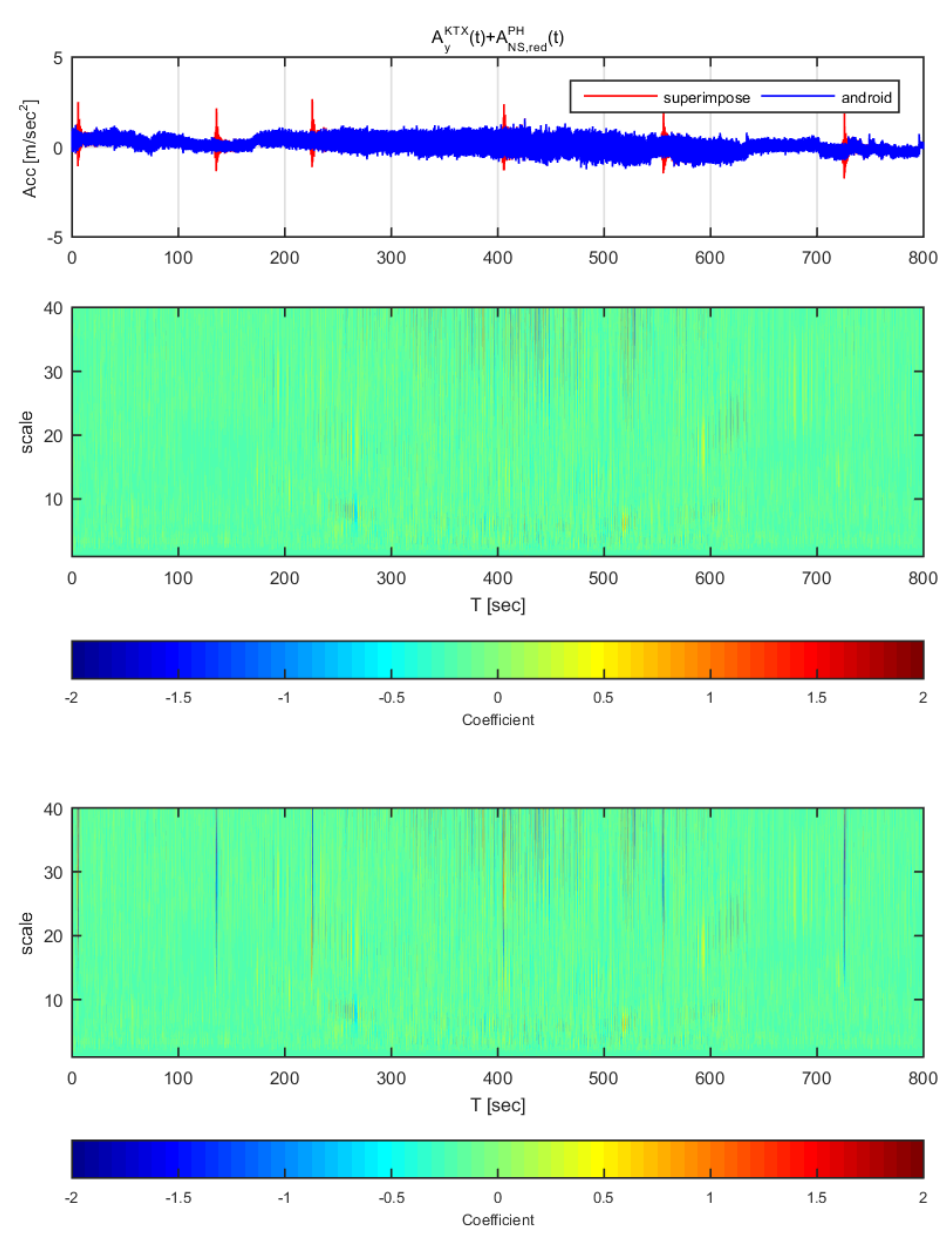
Figure 23. Wavelet transform coefficients for the combination of Korea Train Express (KTX) transverse direction data and Pohang earthquake north-south direction data (adjusted to 2 m/s 2 )